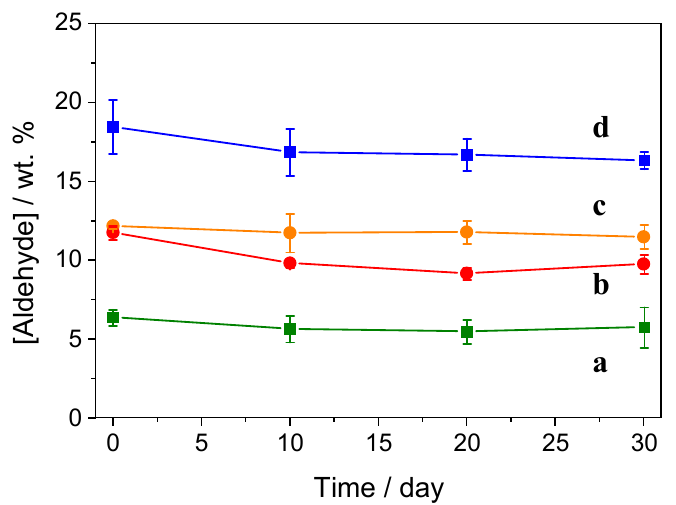
Figure 1. Content of aldehydes (as wt. %) during a period of 30 days in the saponite samples: a = SapC6AN, b = SapC7EN, c = SapC6EN, d = SapC7AN. The aldehyde content was measured by CHN elemental analyses. Environmental conditions: open air, 25 °C, atmospheric pressure.